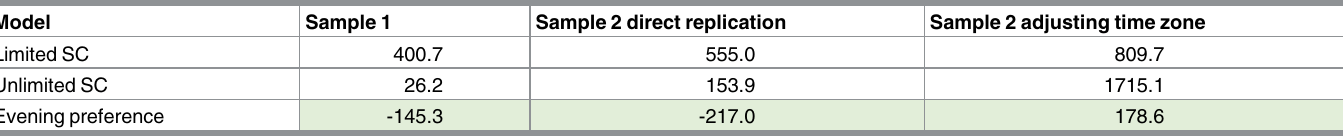
Table 2. Devianceof login data from theoretical models of daily fluctuations in login